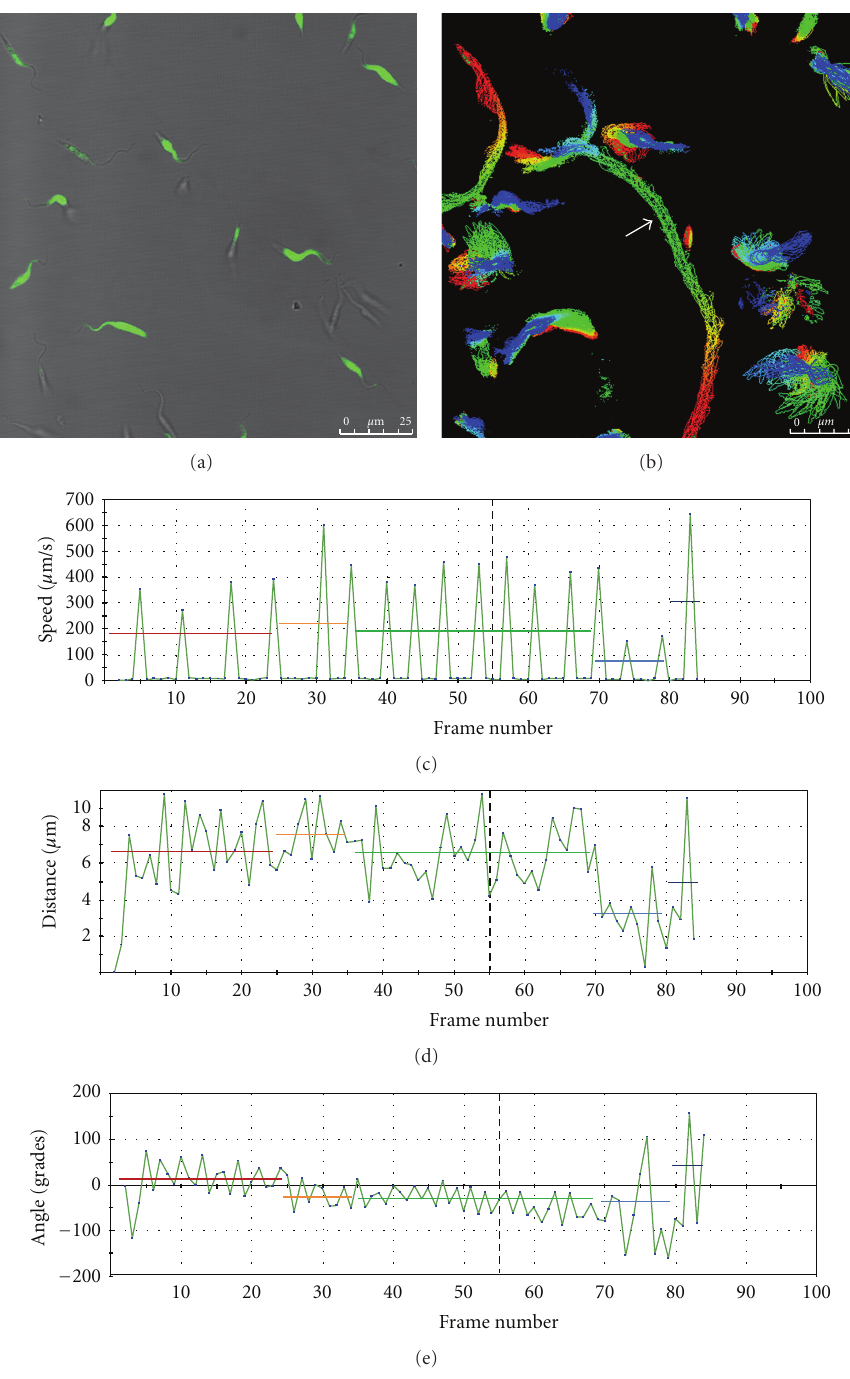
Figure 1: Trypanosoma cruzi motility analysis by time-lapse microscopy. (a) Direct observation of CFSE green fluorescent-labeled free- swimming epimastigotes analyzed by confocal microscopy. (b) Motility traces of epimastigotes. The positions of each individual cell are plotted at 10 frames/sec and recorded for 10 sec/sample. The starting position of each epimastigote is in red. The video clips used to generate these motility traces are available as supplementary material available at doi: 10.1155/2012/520380 (Video 1). The arrow indicates the parasite trajectory analyzed in panels (c, d, and e). The graphics represent the distance (c), angles (d), and speed (e) through consecutive frames of the selected parasite (arrow) of panel b. The color bars indicate the average value of each segment analyzed using the same color scale as the motility